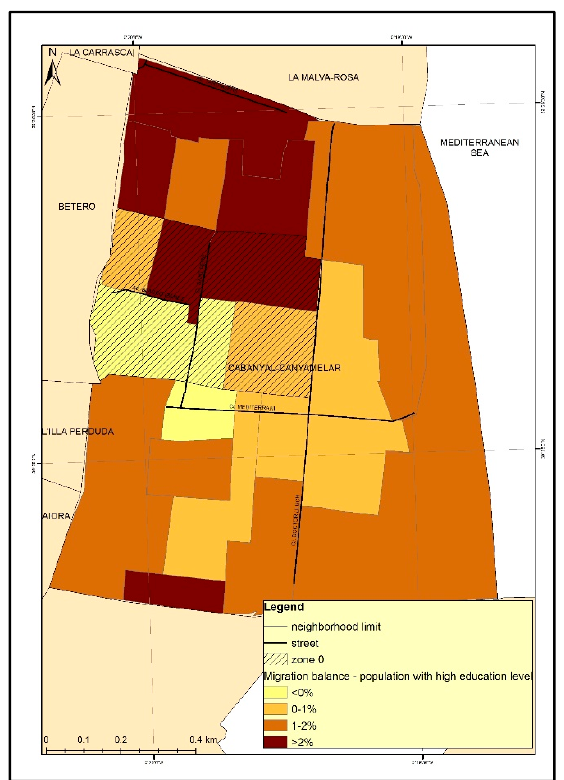
Figure 9. Migration balance of population with high education level in Cabanyal and zone 0, 2014–2016.